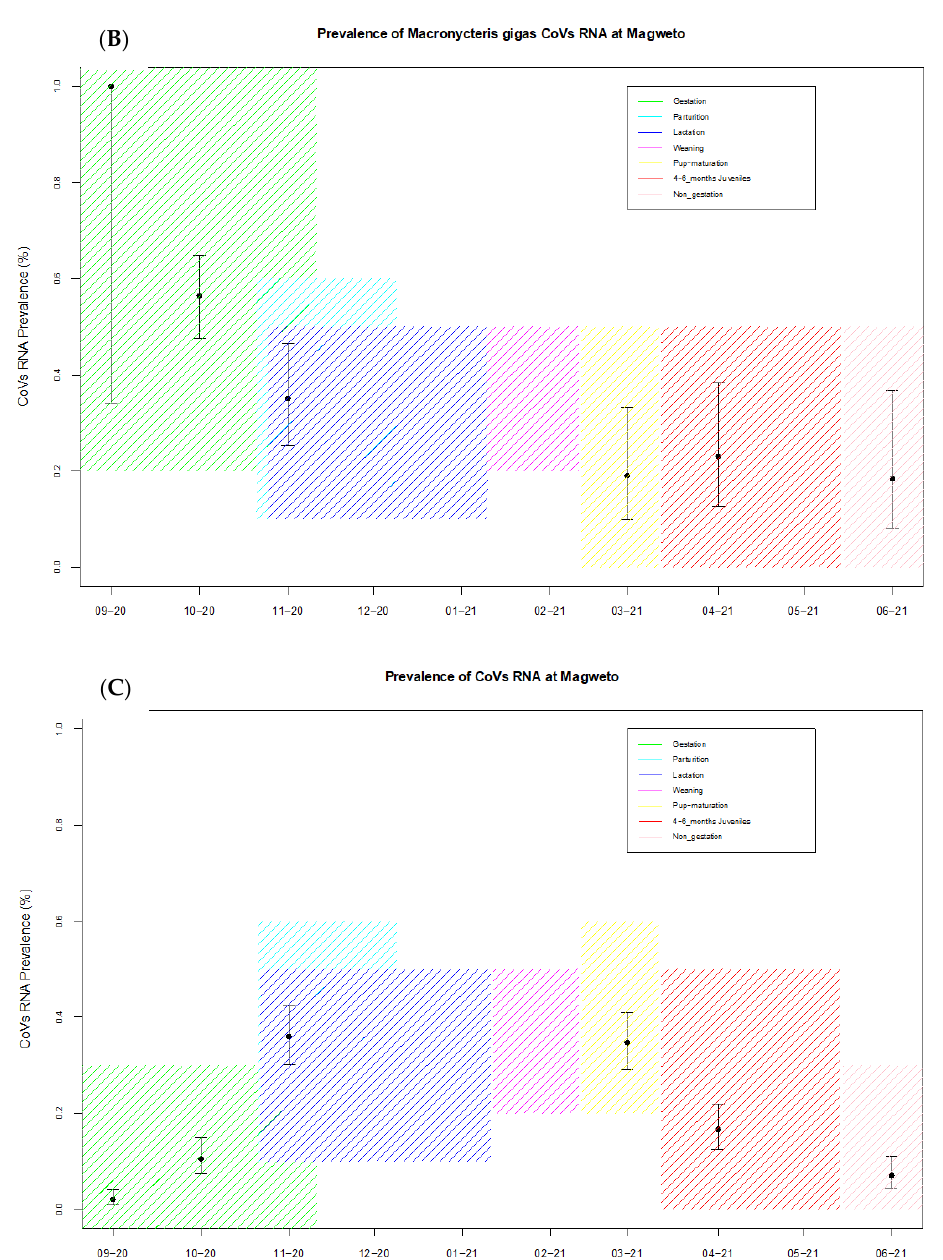
Figure 2. Results of the longitudinal sampling at two sites for coronaviruses. ( A ) Estimation of the coronavirus prevalence (with 95% CI) at Chirundu site, ( B , C ) the same for bats and Macronycteris gigas (respectively) at Magweto cave site. The areas colored green, cyan, navy blue, magenta, red and pink show periods of gestation, parturition, lactation, weaning, 4–6 months old juvenile and non-gestation periods, respectively, observed in the dominant bat species at both sites.